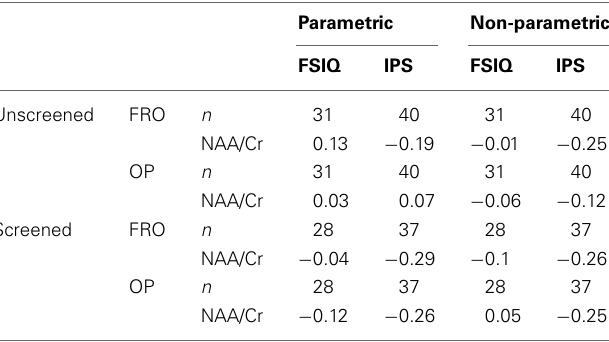
Abbreviations as for Table 2 . Screened and unscreened data analyzed with non-parametric (Spearman’s Rho) and parametric (Pearson Product Moment) correlations for comparison. 3 outlier values ( > ± 2 SD from cohort mean) excluded. Max r = − 0.29 (p = 0.078) for Pearson correlation between FRO NAA and